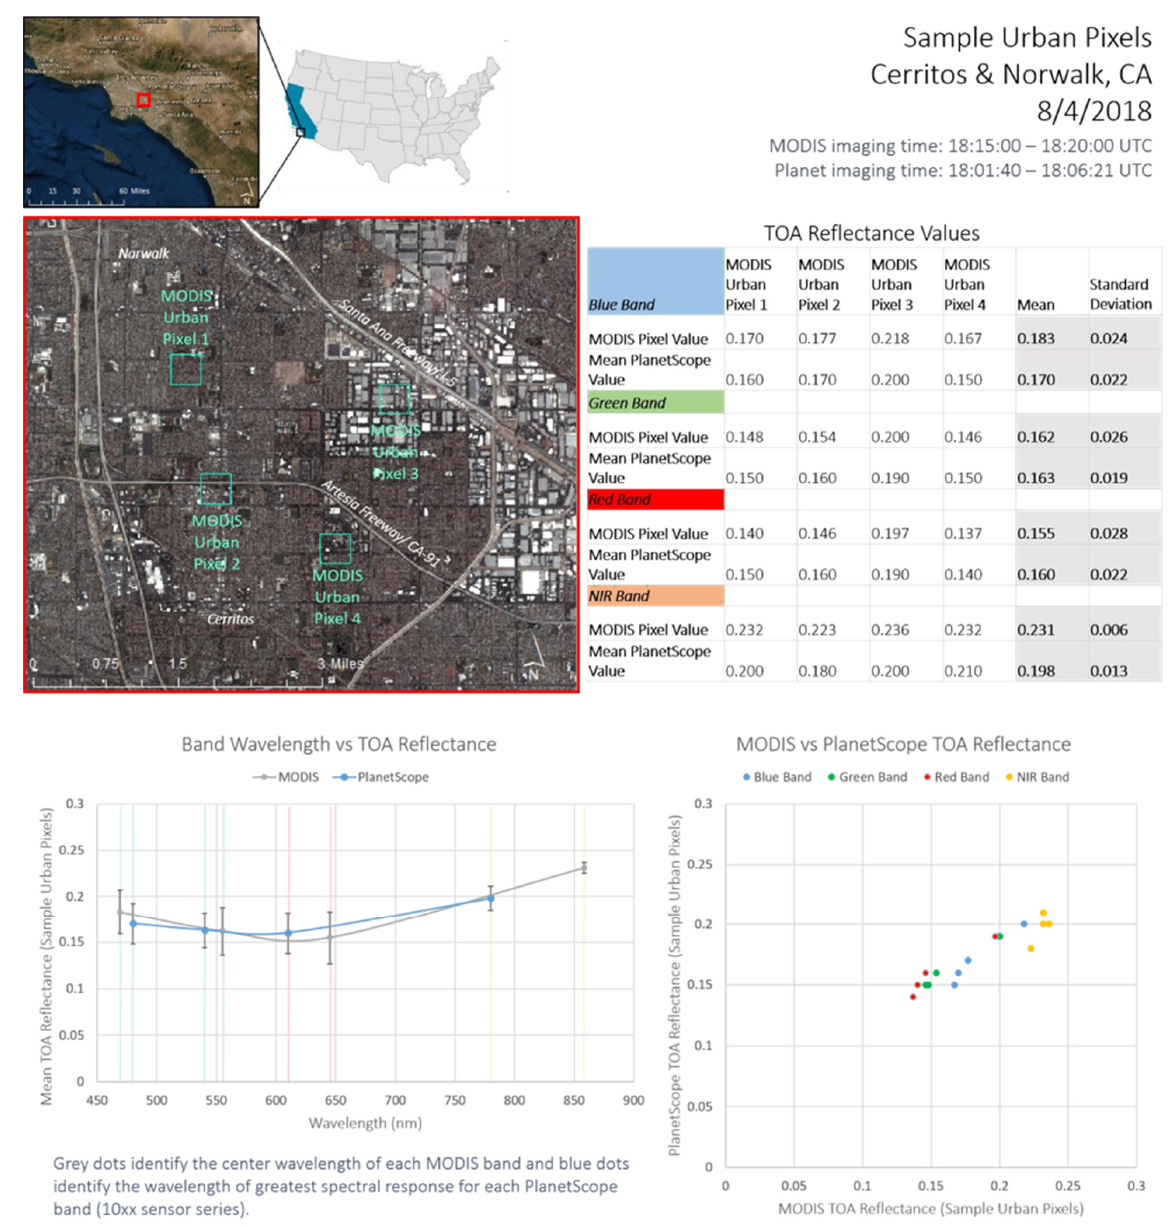
Figure A5. Results from Section 3.2 for pixels sampled over an urban area in the Los Angeles study area on 8/4/2018.